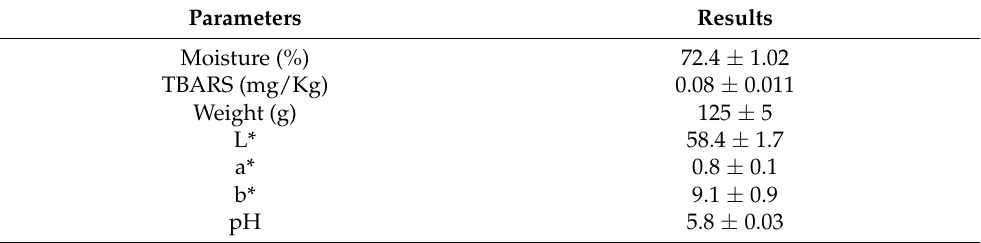
Table 2. Moisture Content, Thiobarbituric Acid Reactive Substances (TBARS), Color Parameters (L*: Lightness, a*: Redness/Greenness, and b*: Yellowness/Blueness), and pH of the Raw Chicken Breast Fillet 24 h